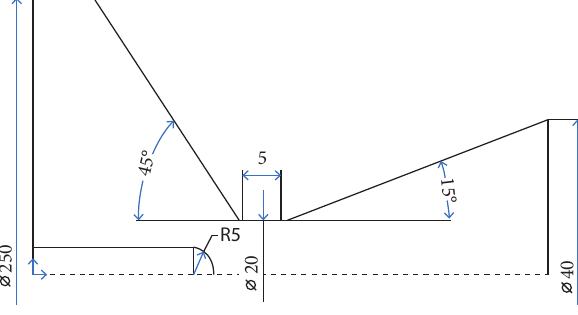
Figure 3. Conical nozzle with straight-cut throat parameters.